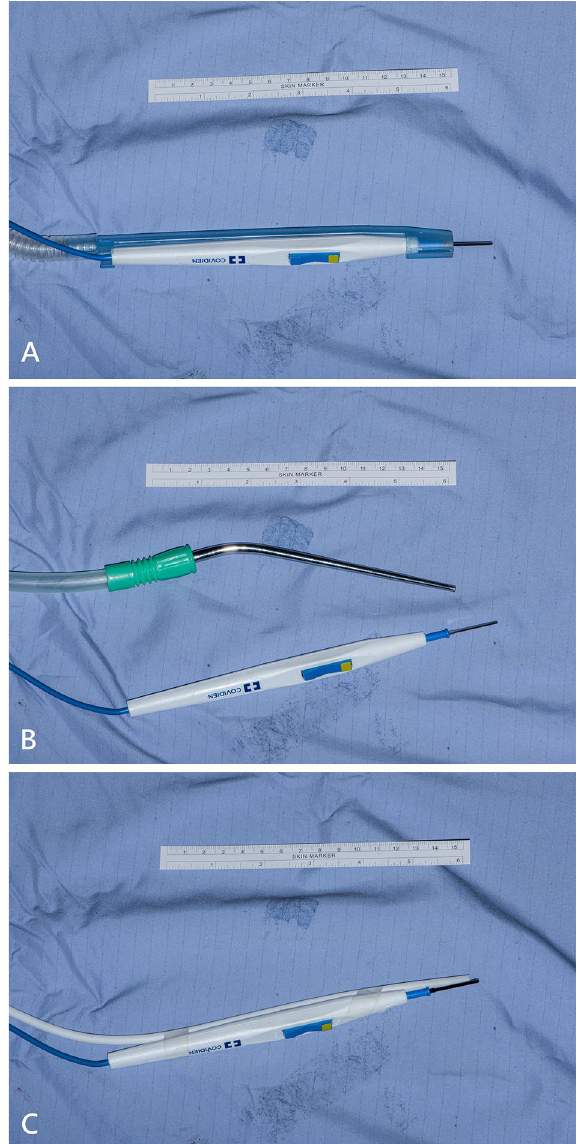
Figure 2. Preparation of various local exhaust ventilation. ( A ) Desktop unit: Medtronic Rapid Vac with the electric scalpel suction adapter (inner diameter 10.0 mm with tip flow 1250 L/min). ( B ) Surgical suction (ENT suction, inner diameter 1.5 mm with tip flow 40.6 L/min). ( C ) PAHSCO urethral catheter (inner diameter 2.5 mm with tip flow 29